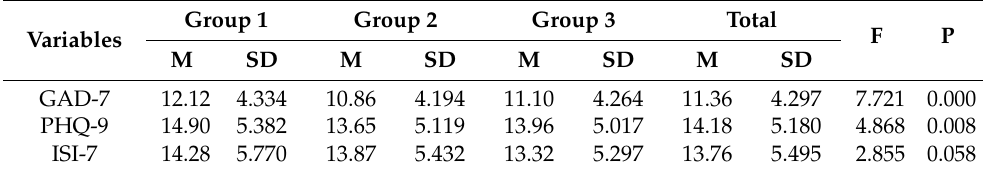
Table 3. One-way Multivariate Analysis of Variance.